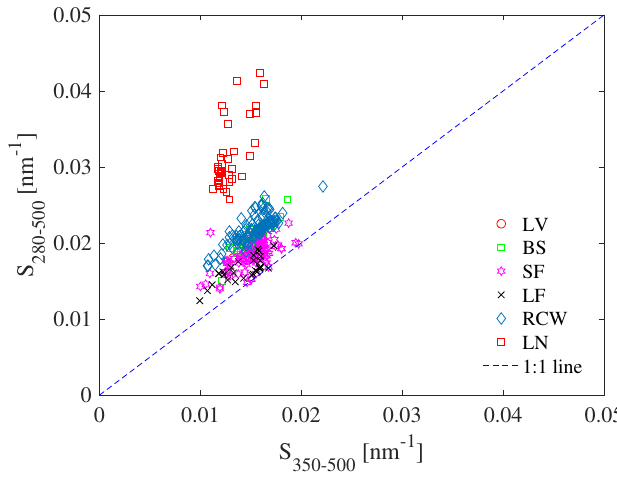
Figure 3. Scatter plots of the CDOM absorption spectral slope derived using nonlinear fitting methods for all study sites for S 350 − 500 versus S 280 − 500